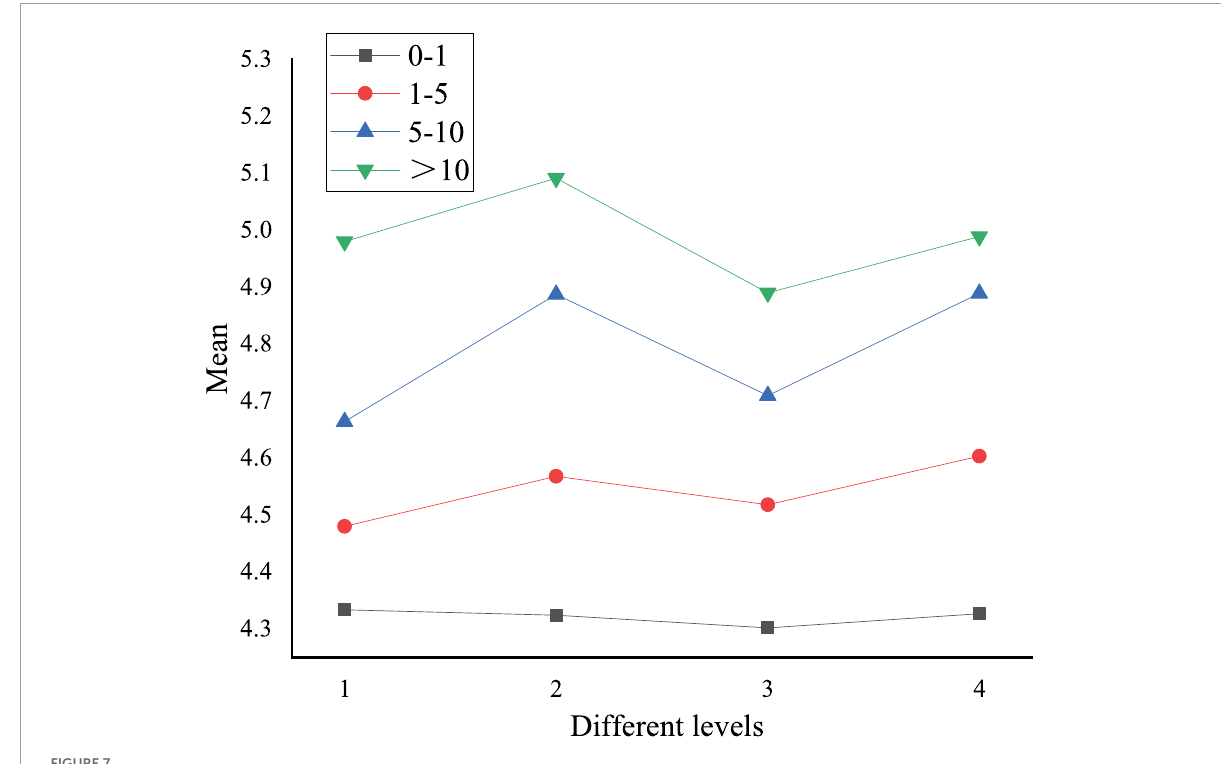
FIGURE7 The influence of reading volume of art journals on college students’ national cognition and cultural